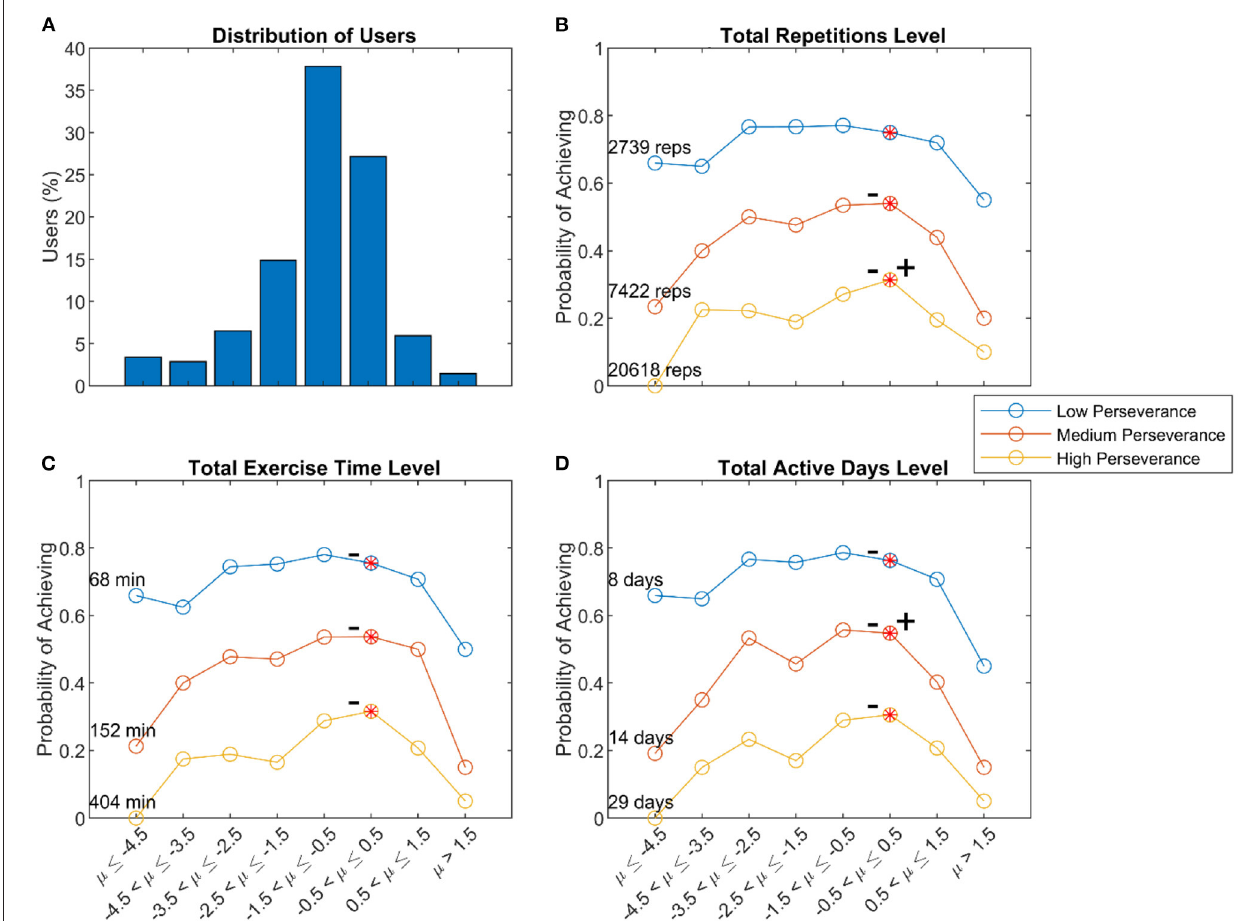
FIGURE 8 | Relationship of steadiness curvature and perseverance. (A) Distribution of users with various steadiness curvatures. Probability of achieving low, medium, and high levels of perseverance, defined to be the 25th, 50th, and 75th percentiles of three measures of usage – total repetitions (B) , total exercise time (C) , and total active days (D) – measured across 8 weeks of use. The – and symbols indicated significant declines from the peak value to the left and right, respectively, using the + “sweet spot” test described in the methods ( p < 0.05). In the above analysis, user’s initial repetition rates, success rates, and steadiness curvature included data from Week #1, and we used them to predict overall perseverance, which also included data from Week #1. To test if including data from Week #1 biased the patterns we observed, we repeated the above analyses with measures of perseverance calculated over Weeks #2–8. The results of these analyses were similar to the results presented above.